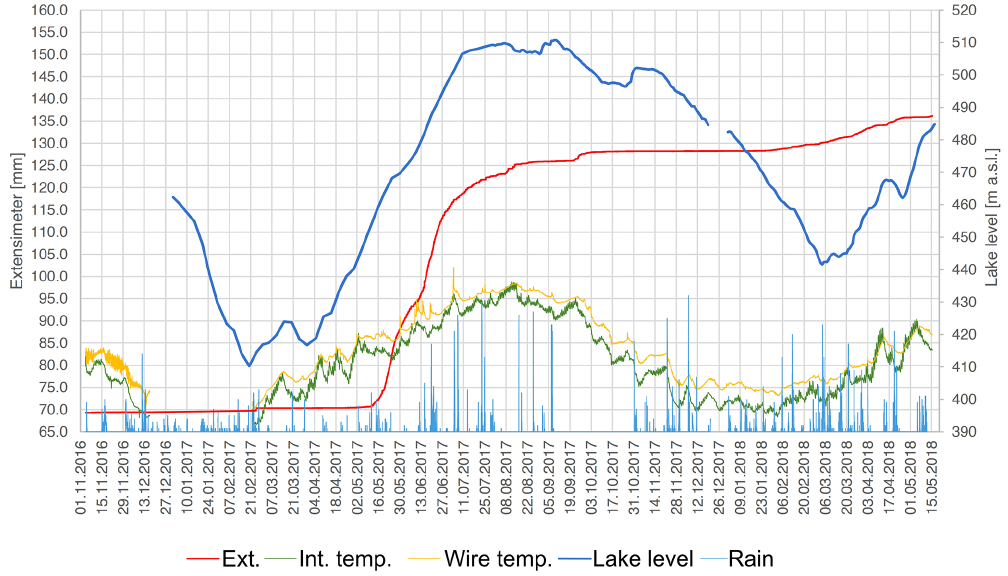
Figure 15. Data acquired from one of the two digital extensometers located at the upper scarp of the western landslide (location Trench 2; Fig. 7a). The blue line shows the lake level, the red line the extension, the yellow line the external (wire) temperature, the green line the internal temperature and the light blue lines the amount of